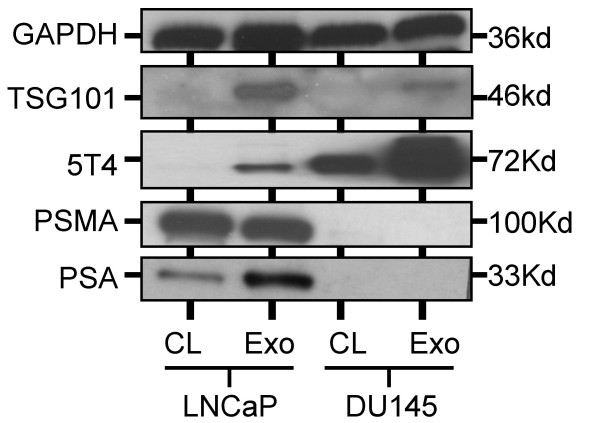
Characterising exosomes produced by LNCaP-prostate cancer cell line. Prostate cancer cell lines (LNCaP and DU145), as indicated, were maintained in culture as a source of positive-control prostate cancer exosomes (for subsequent analyses). Whole cell lysates (CL) or exosomes (Exo) were analysed by SDS-PAGE (5 μg/well), with a panel of antibodies as indicated.